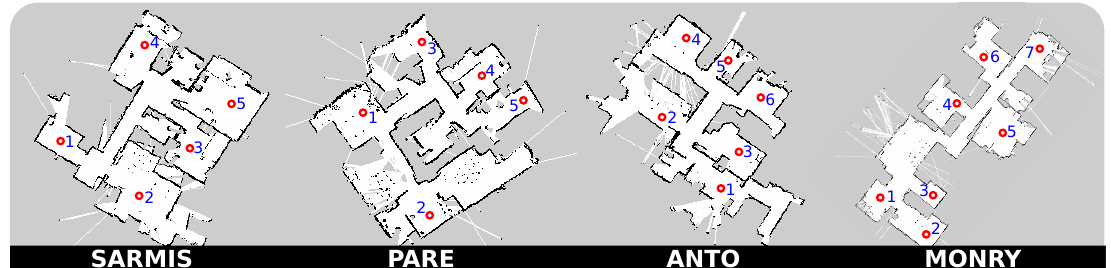
Figure 4. Floor-plans of the four houses where navigation will be tested. These geometric maps are built by deploying a mobile robot in the house and teleoperating it while running a SLAM algorithm based on 2D laser range measurements.